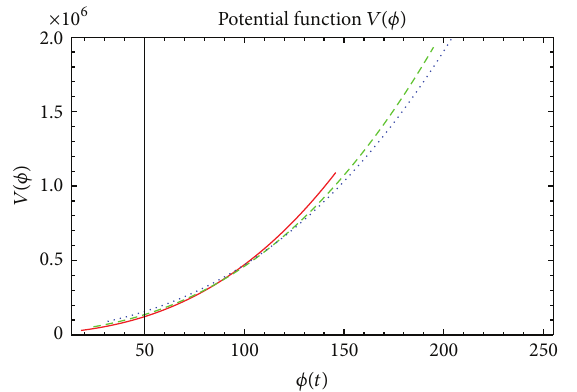
Figure 3: Plot of 𝑓(𝑅,∇𝑅) quintessence potential 𝑉 versus 𝜙(𝑡) for 𝑛 = 1 (red), 𝑛 = 2 (green), and 𝑛 = 3 (blue).